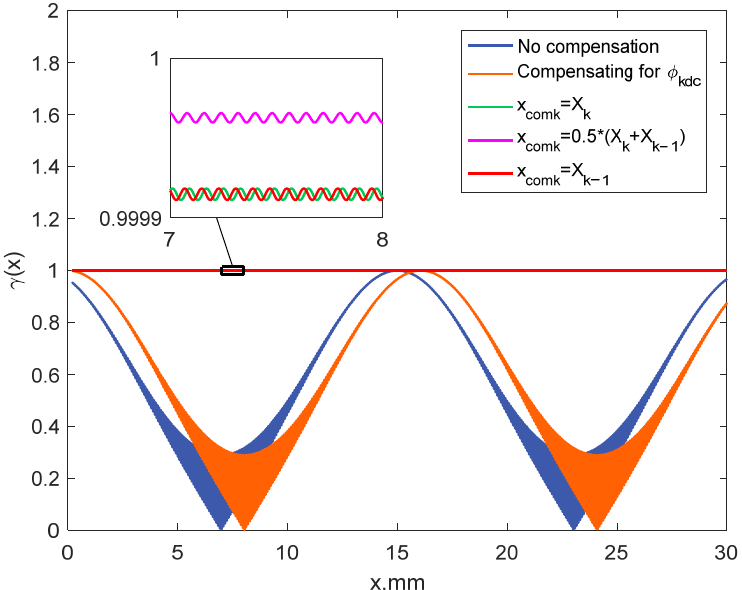
Figure 6. Exposure contrast under the condition of f k = g ( X k ) with different δ k .